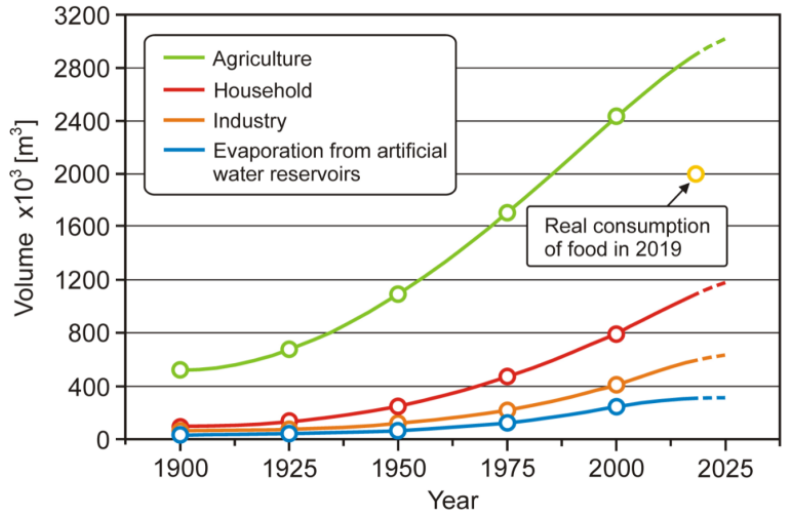
Figure 2. Changes in water consumption in the world [11].